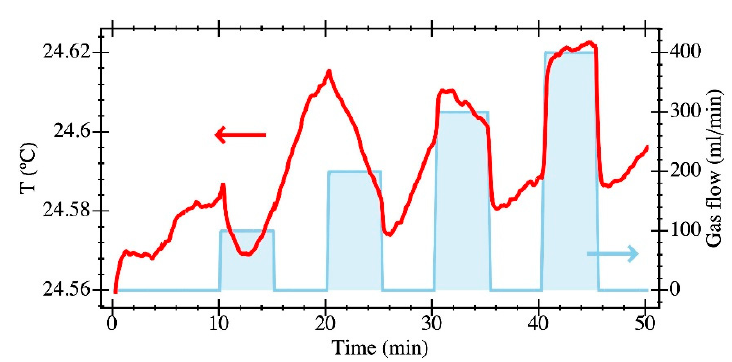
Figure 11. Time evolution of the temperature during the gas flow experiment measured into the sealed chamber (red line). The gas flow is also depicted in light blue.